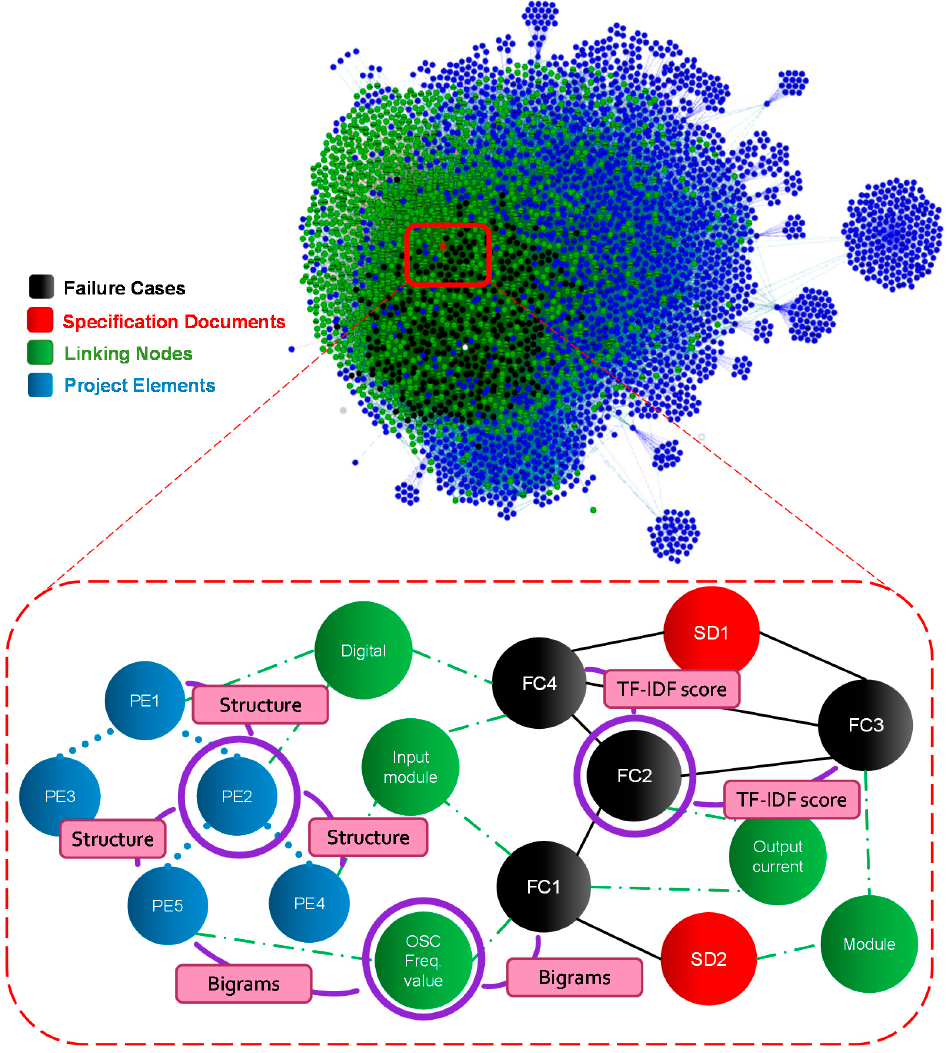
Figure 4. The construction of the multidimensional knowledge graph from chip-design documents. Four types of nodes are defined, along with their relations. Relations exist amongst nodes of the same type and among those of different types.